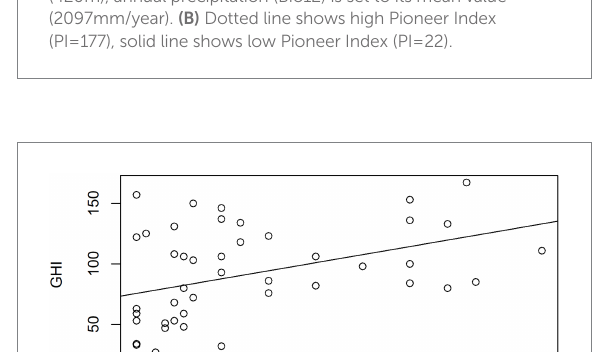
FIGURE 5 General linear model for GHI in Nimba: GHI = exp. (1.76 + − 0.000269 × ALT + − 0.0105 × PI +0.000000514 × ALT 2 + − 0.00181 × Bio12); Adj. R 2 is 63%, n = 454, all terms are significant ( p < 0.05). (A) Dotted line shows model fit at high altitude (1,660 m), solid line shows model fit at low altitude (420 m), annual precipitation (Bio12) is set to its mean value (2097 mm/year). (B) Dotted line shows high Pioneer Index (PI = 177), solid line shows low Pioneer Index (PI =